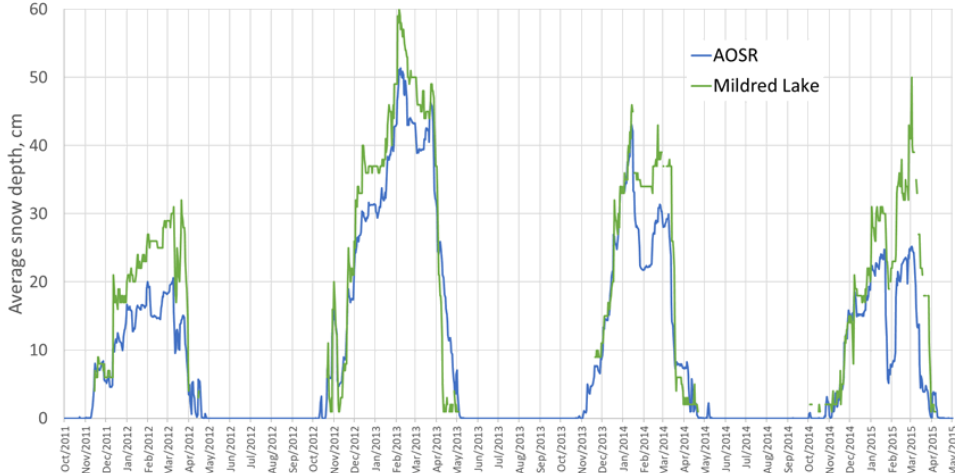
Figure 9. Daily averaged model-simulated (blue) and observed snow depths (green) (cm) in 2012–2015 in the AOSR. Modelled values are averaged over the entire AOSR domain, and the observation site is Mildred Lake, Alberta, a few kilometres east of the Syncrude oil sands upgrader.